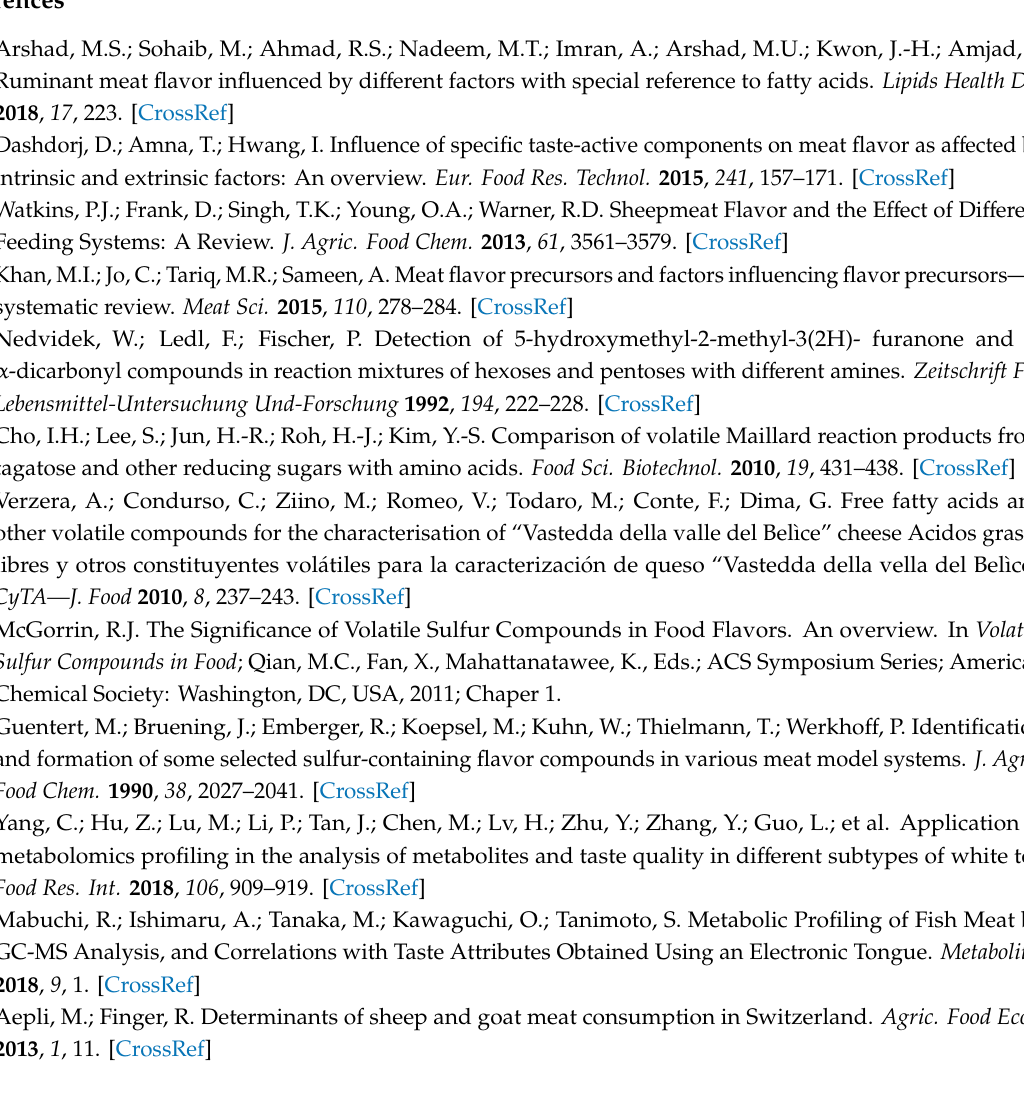
Table S1: All di ff erential expressed metabolites compared between the two